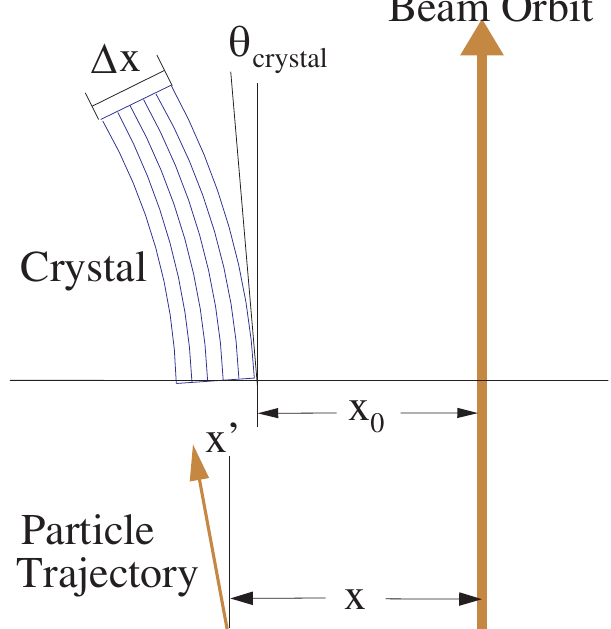
FIG. 2. (Color) Geometry used to calculate the crystal